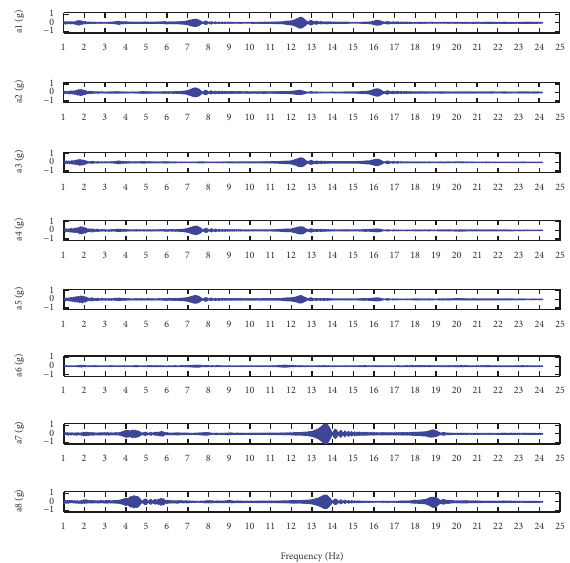
Figure 4: Nonconnected (NC) configuration, acceleration mea- sured by sensors a1–a8. Sine sweep frequency test PGA